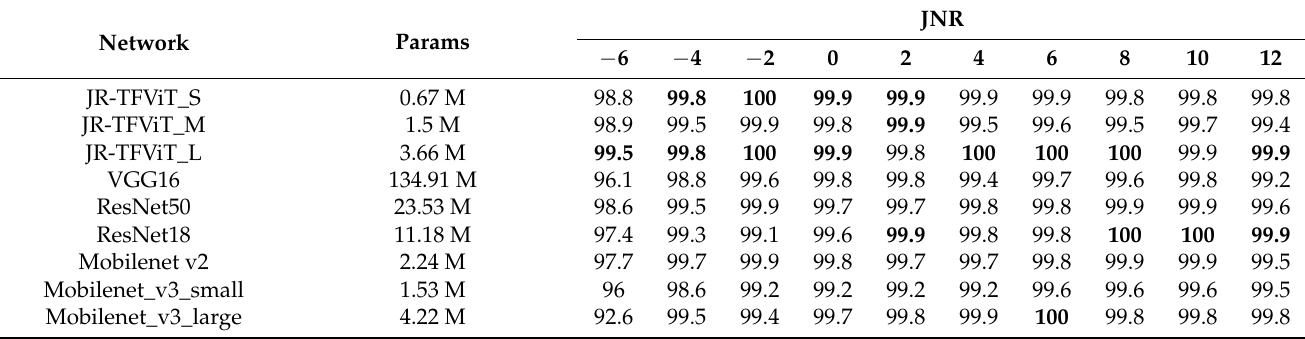
Table 5. The Kappa of the nine networks in different JNR